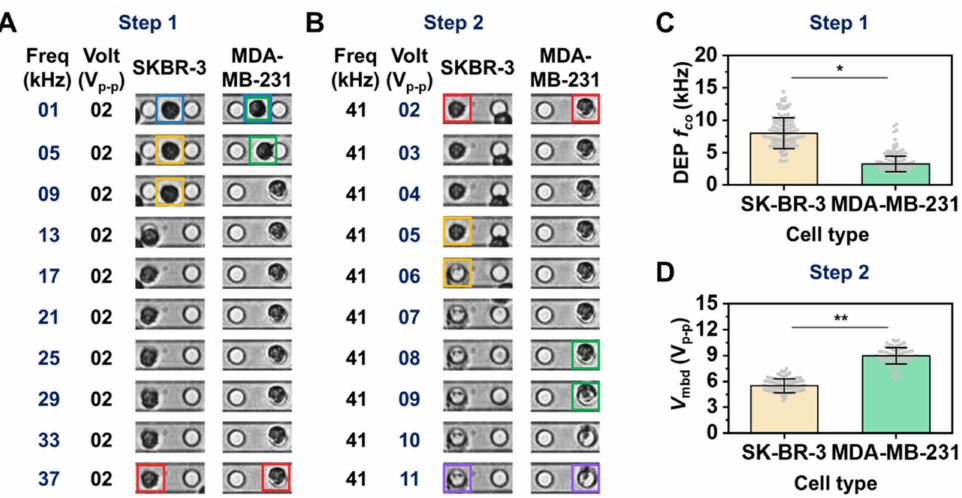
Figure 2. Comparison of f co and V mbd for SKBR-3 and MDA-MB-231 cells. ( A , B ) Time sequential images showing cell transitions and alterations over increments of input frequency ( A ) and input voltage ( B ). The blue color boxes show two representative cell that trapped under negative DEP force. The yellow and green color boxes in ( A ) mark the places where SKBR-3 cell and MDA-MB- 231 cell were departed from the center of blue color box position by the transition of DEP force direction, respectively. The yellow and green color boxes in ( B ) mark the places where the transition of brightness within region of SKBR-3 cell and MDA-MB-231 cell was observed by cell membrane rupture following the increase of the input voltage, respectively. The red color boxes show two representative cell that trapped under positive DEP force. The purple color boxes show both ruptured cells by membrane breakdown. ( C , D ) DEP f co ( C ) and V mbd ( D ) for the comparison between the above two cell lines. Each parameter was obtained using cell image analysis (see Materials and Methods). Each gray dot denotes DEP f co and V mbd data for an individual cell. The two sample t -test (two-tailed) was used to check the significance of a difference (* p and ** p < 0.001). The measurement procedure to obtain the average f co and V mbd with standard division was repeated three times. More detailed measurement information is provided in Supplementary Materials Tables S4 and